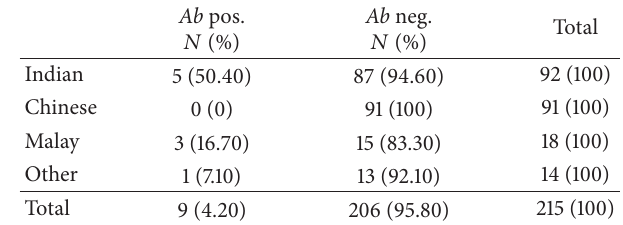
Table 4: Prevalence of Bacillus cereus according to Helicobacter pylori status.